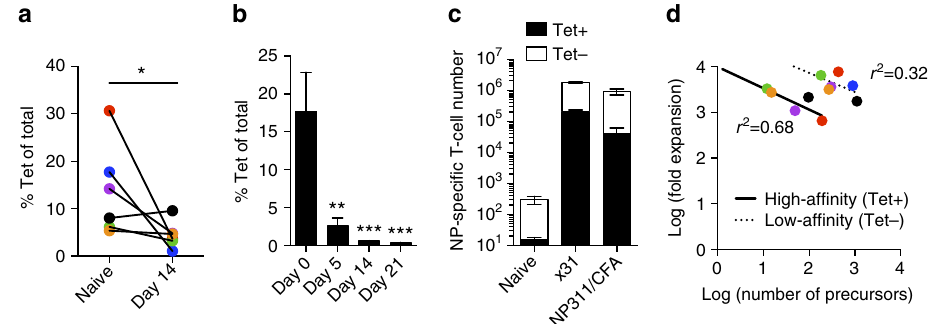
Figure 5 | Low-affinity CD4 þ T cells predominate CD4 þ T-cell immune responses. Each point is a unique antigen-specific population: MOG 38–49 (blue), GP 66–77 (red), Aasf 24–32 (purple), FliC 427–442 (green), NP 311–325 (orange), 85b 280–294 (black) and MOG 38–49 from MOG KO (brown). ( a ) Frequency of Tet þ CD4 þ Tcells in the naive and day 14 immunized repertoires (data shown as mean frequency for each antigen, paired Student’s t -test, * P o 0.05). ( b ) Frequency of MOG-Tet þ cells in the total MP þ Tcells during the immune response to MOG 35–55 /CFA immunization (data shown as mean ± s.e.m., one-way analysis of variance, ** P o 0.01, *** P o 0.001 with day 0 as a reference value). ( c ) Enumeration of Tet þ and Tet (cid:2) NP311-specific CD4 þ T-cell contribution from either naive, day 10 post x31 influenza infection, or NP311/CFA immunizations (naive data taken from Fig. 4a, expanded data contain four independent experiments, with two mice each, data represented as mean ± s.e.m.). ( d ) Plot of precursor number (log transformed) versus fold expansion (log transformed) of high-affinity and low-affinity T cells as identified by tetramer, LDA and MP.